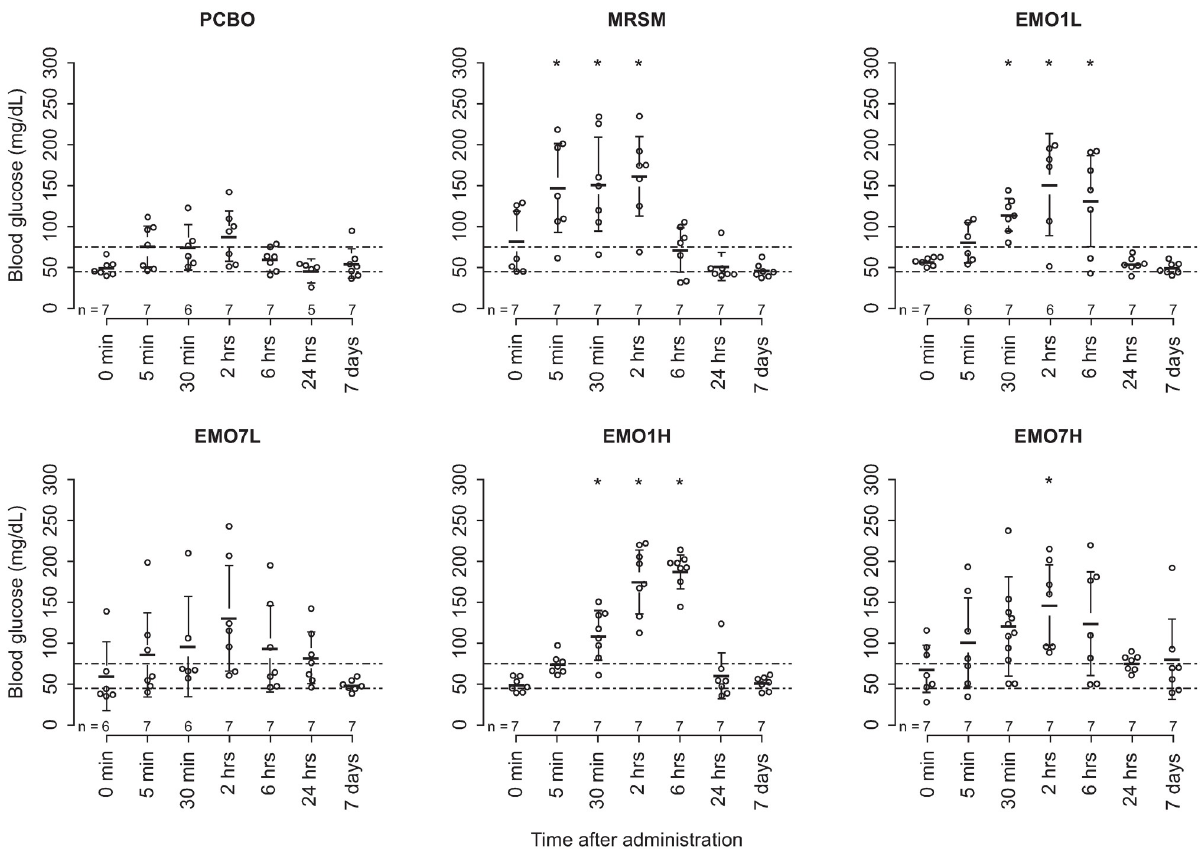
Fig 3. Blood glucose concentrations observed pre- and post-treatment commencement with emodepside by experimental group in zebu (Ngaounde´re´ Gudali) cattle (B . t . indicus) . Glucose concentration in venous blood was determined by test strip assay (MediTouch 2 blood glucose monitor, Medisana, Neuss, Germany). Treatment groups were single dose, or seven daily doses, of emodepside at 0.15 mg/kg (EMO1L, EMO7L) or 0.75 mg/kg (EMO1H, EMO7H), placebo (PCBO [solketal]) daily for seven days, and melarsomine (MRSM) 4 mg/kg every other day for three days as a positive control. Points represent single observations in individual animals. Bars and whiskers represent group means with 95% CI. Normal distribution was assumed because of the even distribution of individual blood glucose values above and below each group mean at each timepoint. The broken horizontal line represents the standard reference range for bovine blood glucose concentrations. Timepoints where the group-level blood glucose 95% CI was elevated above this range are marked with an asterisk. No formal statistical comparisons were made. EMO1H, emodepside, 0.75 mg/kg, single dose; EMO7H, emodepside, 0.75 mg/kg, daily for seven days; EMO1L, emodepside, 0.15 mg/kg, single dose; EMO7L, emodepside, 0.15 mg/kg, daily for seven days; MRSM, melarsomine, 4 mg/kg, every other day for three days; PCBO, placebo.